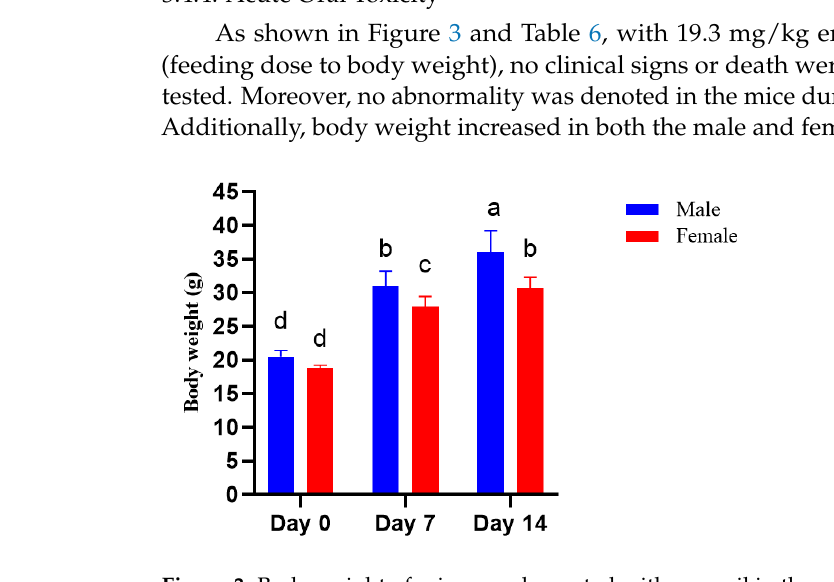
Table 6. General appearance and behavioral observations of the animal treated orally with emu oil in the acute test.